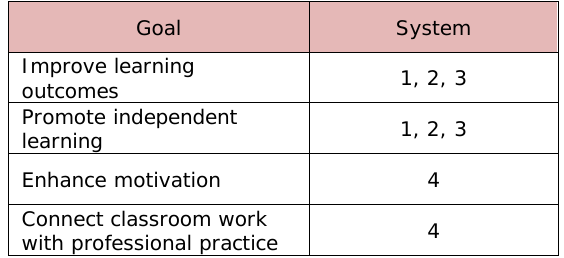
Table 4. “Assessment system used to evaluate each of the goals”. Source: authors of goals: Improve learning outcomes and